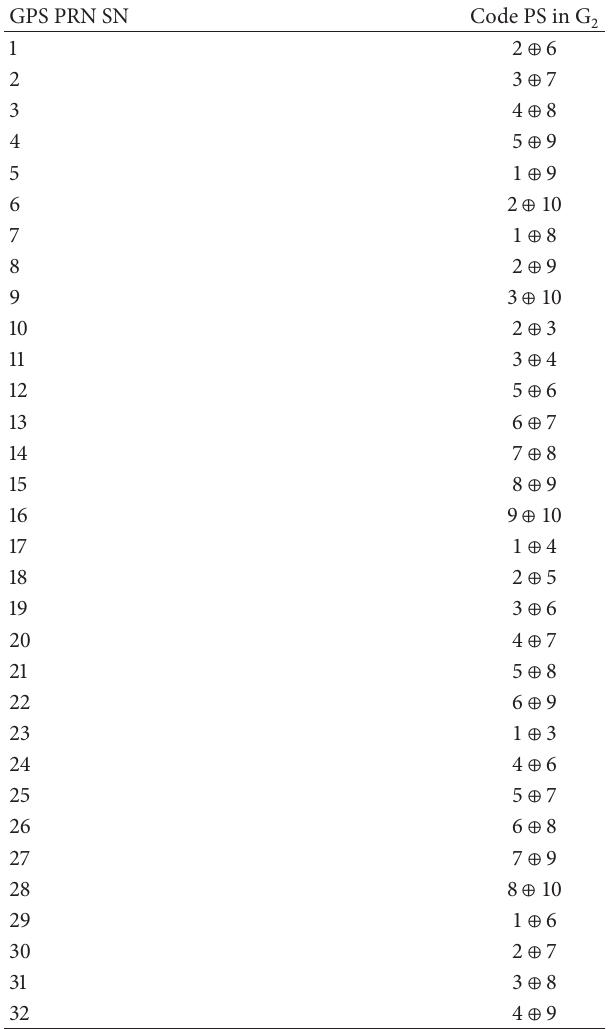
Table 1: C/A-GPS code phase assignment. GPS PRN